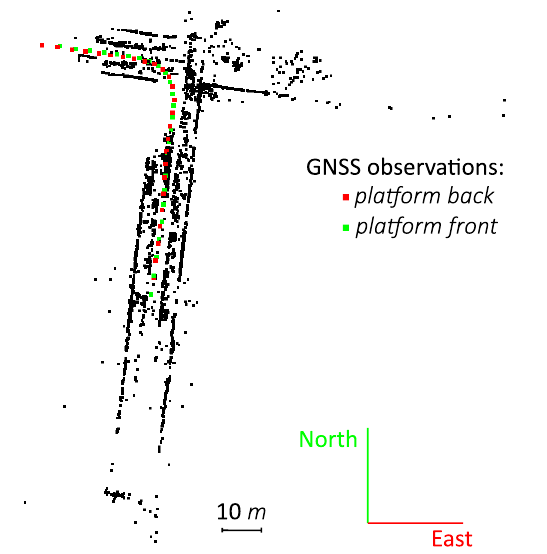
Figure 5. Data acquisition scenario. Black: sparse tie points; the GNSS observations of platform back and platform front are shown red and green, respectively.